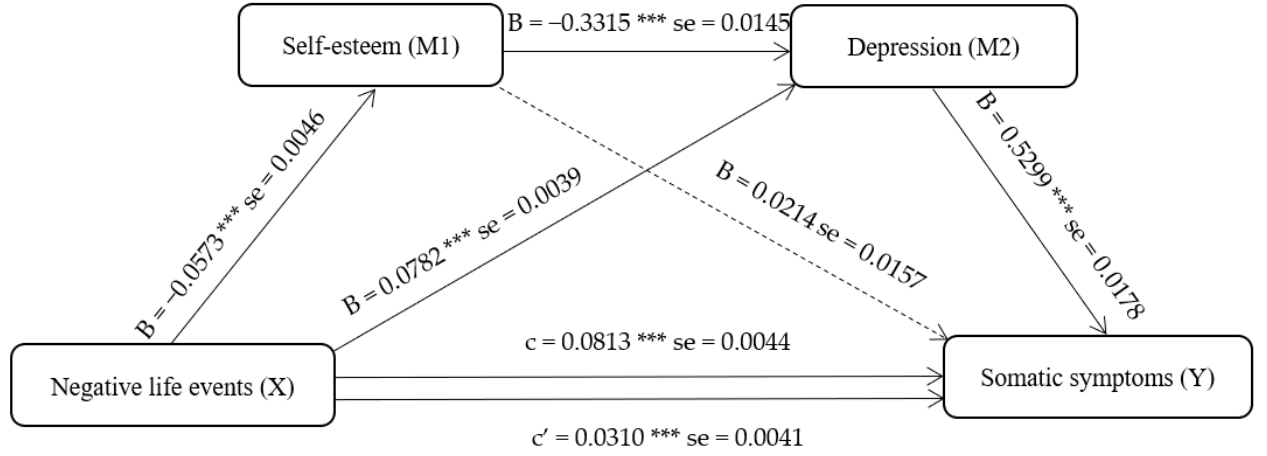
Figure 1. Serial multiple mediation of self-esteem and depression in the relationships between negative life events and somatic symptoms with non-standardized beta values and standard errors. Note: *** p < 0.001. Table 6. Mediating effects in the mediation